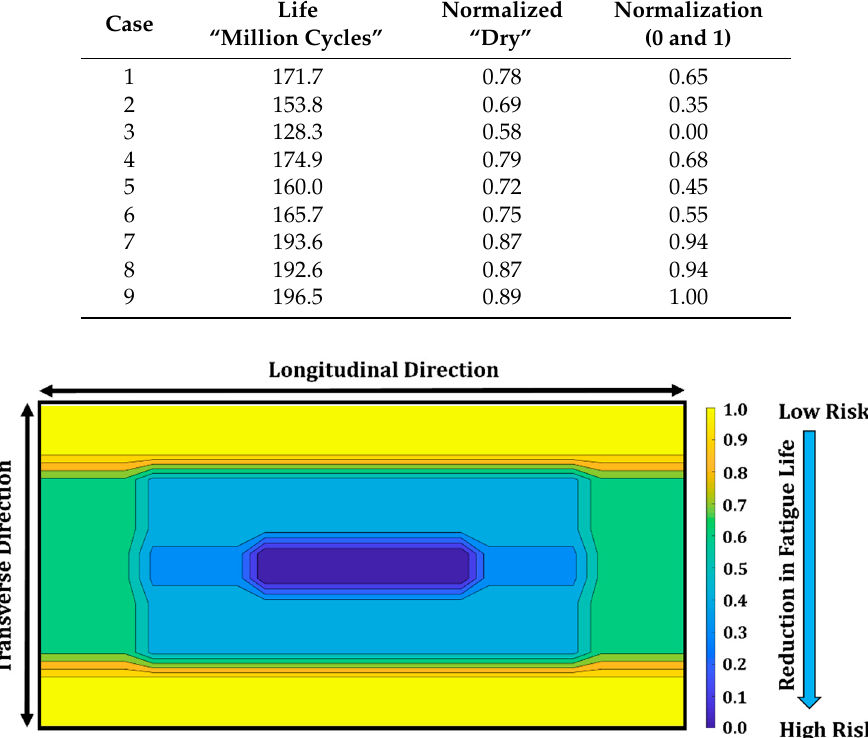
Figure 23. Hazard map for the wetting locations of higher risk.